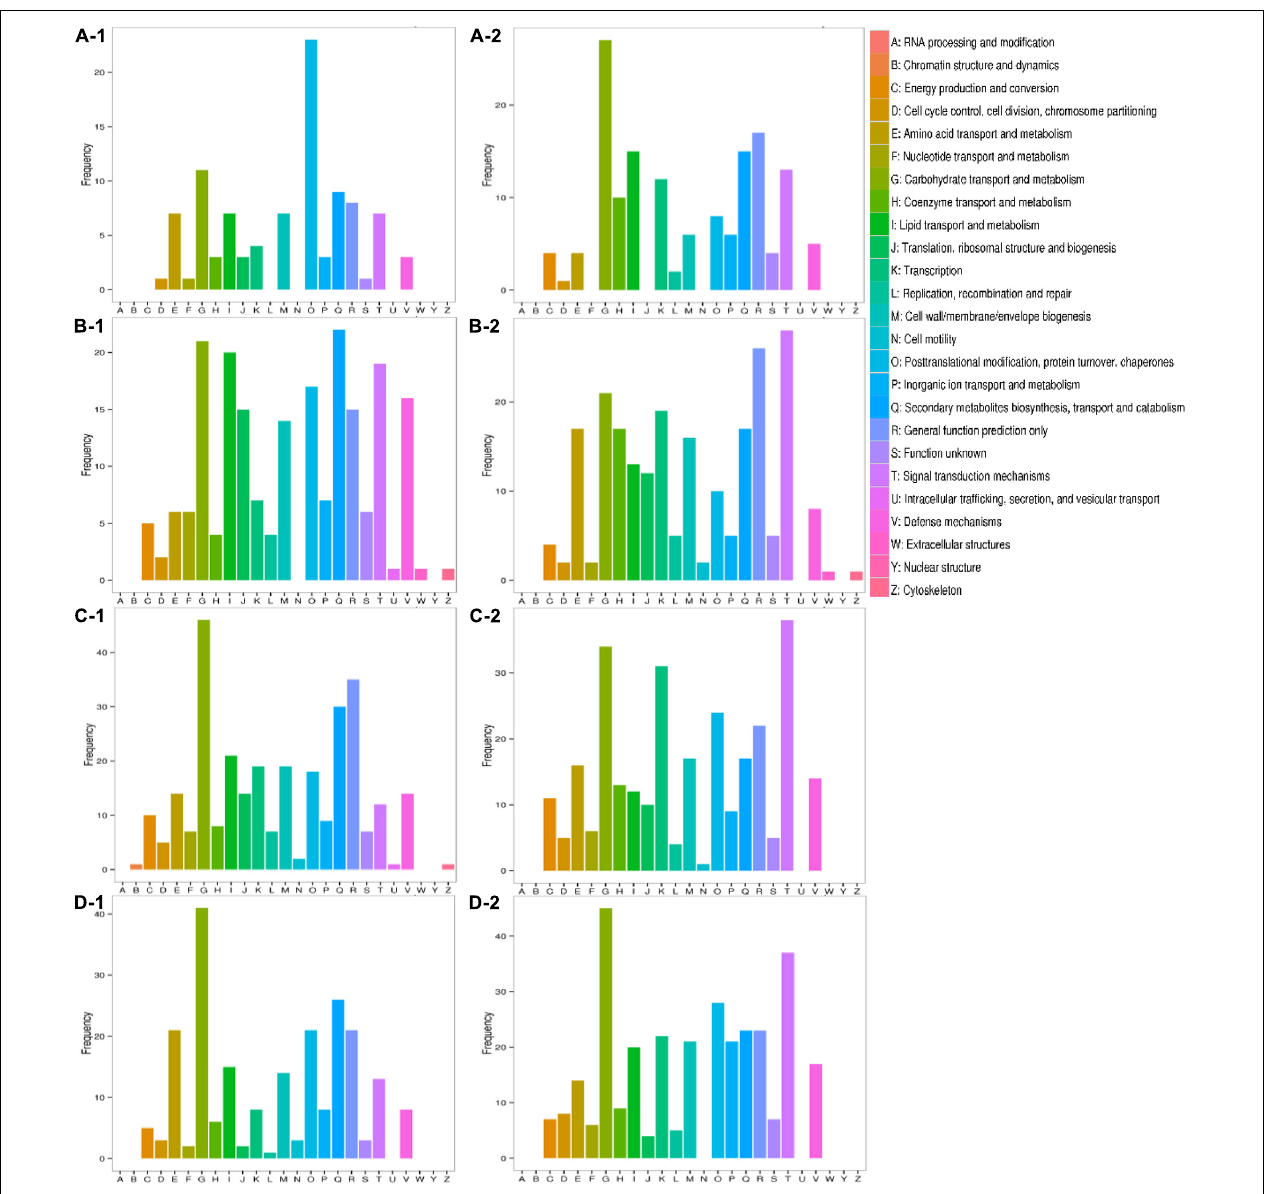
FIGURE 7 | Functional classification in Clusters of Orthologous Groups of proteins (COG). Capital letters on the X-axis indicate the COG categories listed on the right of the histogram, and the Y-axis indicates the number of transcripts. (A) QHCK vs. QHS, (B) QHCK vs. BYCK, (C) QHS vs. BYS, and (D) BYCK vs. BYS, -1 up -2